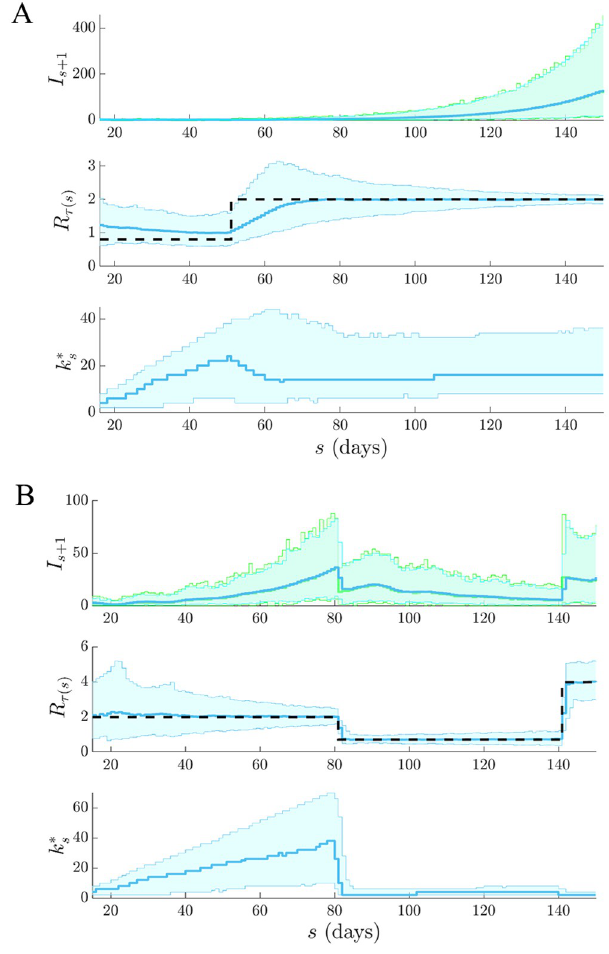
Fig 5. Real-time APE sensitivity to increasing transmission. We simulate 10 3 independent epi-curves under renewal models with sharply (A) increasing and (B) recovering epidemics. Top graphs give the true (green) and predicted (blue) incidence ranges, the middle ones provide estimates of R s under the final k � how successive k � choices from APE vary across time and are sensitive to real-time elevations in s